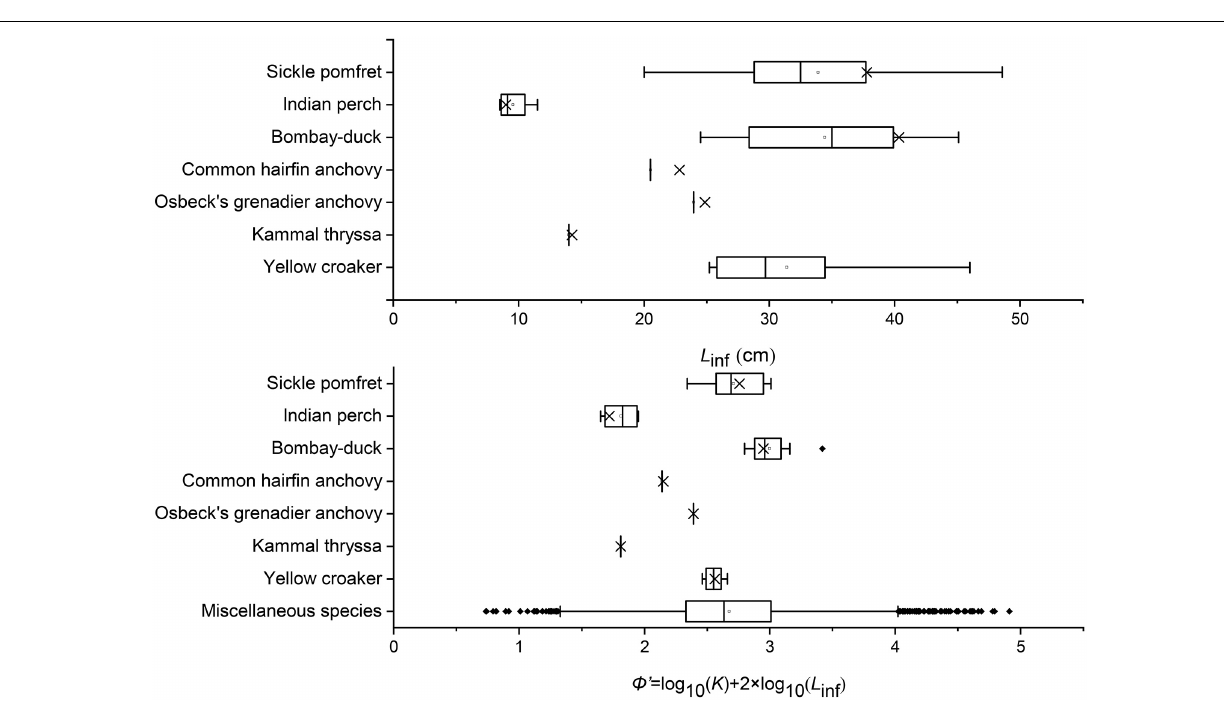
A scatter diagram of F / F MSY and B / B MSY is usually used to illustrate exploitation status of a relevant fishery stock (such as Figure 3 in Froese et al., 2018b). The LBB model does not